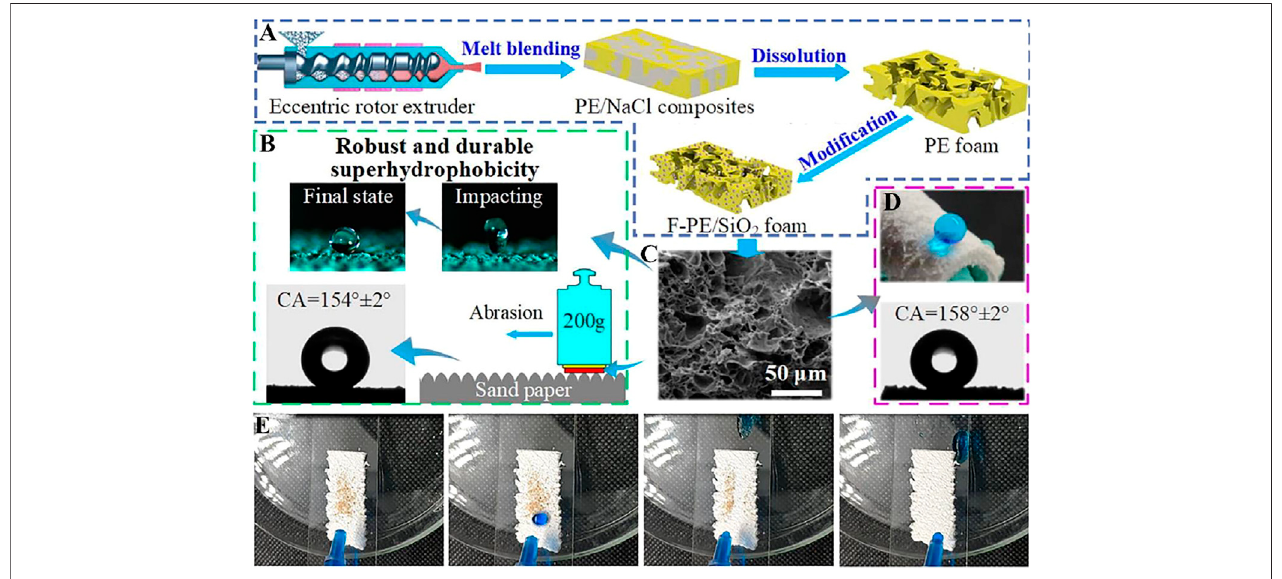
FIGURE 5 | (A) PE foam and F-PE/SiO 2 foam schematic diagram of foam plastic preparation process. (B) Illustration of sandpaper abrasion for the foam surface. (C) TheSEM image ofF-PE/SiO 2 foam. (D) Water on thesurface ofF-PE/SiO 2 foam. (E) Picture of30 ° inclined F-PE/SiO 2 foam polluted bysands before and after water drop washing (Wu et al.,